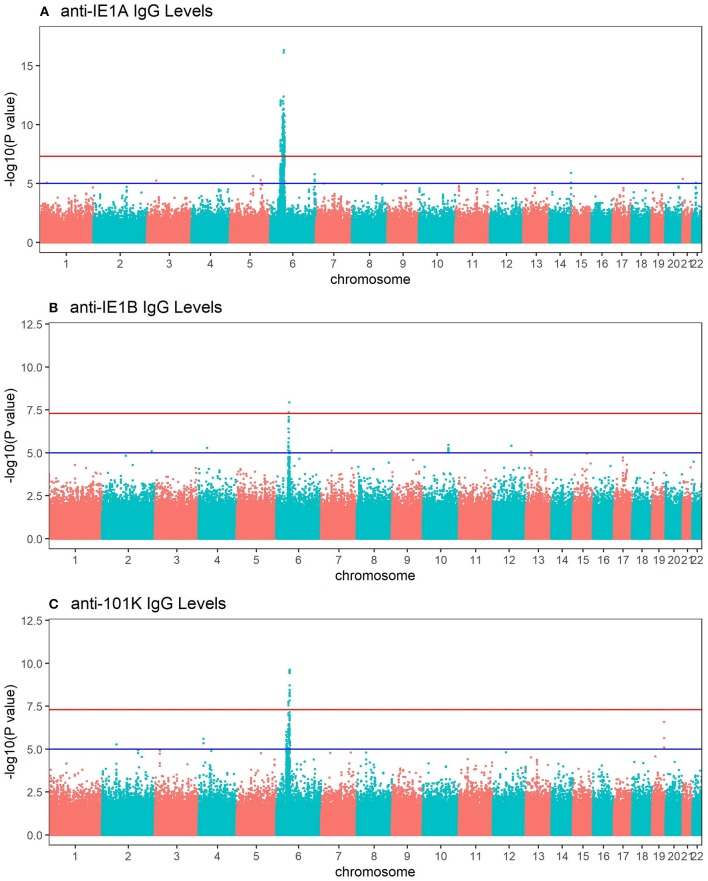
Manhattan plots visualizing associations between SNPs and anti-HHV-6A/6B protein IgG response levels. GWAS data (n = 6,396 MS cases and n = 5,530 controls from the established MS cohort) obtained through linear regression models showing associations between SNPs and IgG response (Log10 levels) against (A) IE1A, (B) IE1B and, (C) 101K. Red lines indicate GWAS significance level of 5 ×10−8 (–log10 = 7.3 on the y-axis) and blue lines indicate suggestive association (p = 10−5). Analysis was carried out jointly in MS cases and controls and adjusted with age, sex, cohort type, and case status.